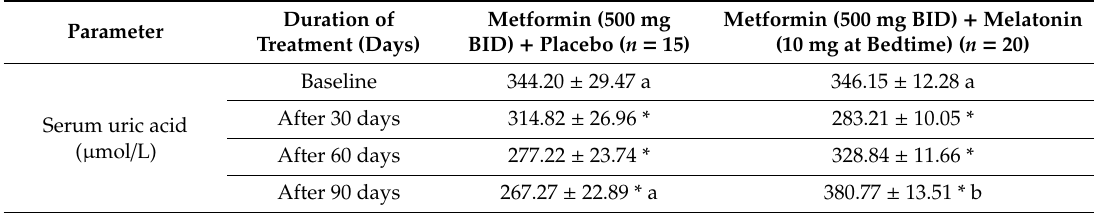
Table 5. E ff ect of treatment with metformin-melatonin versus metformin-placebo on serum uric acid level in MEBS